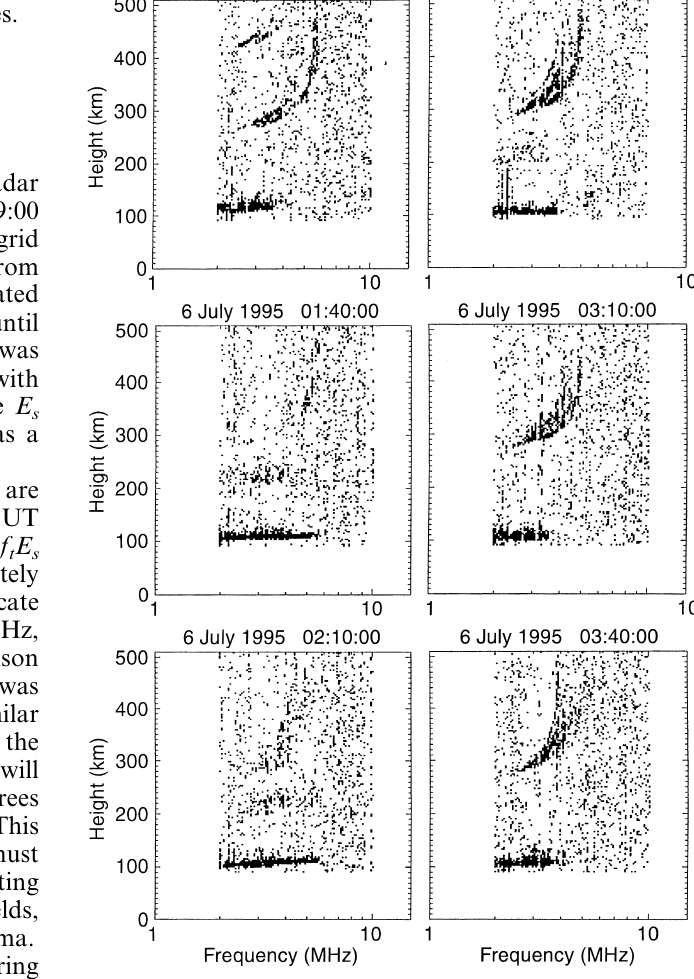
Fig. 4. Ionograms during a period of intense HF backscatter from ~01:00 to 04:00 UT 6 July 1995 obtained with a digital ionosonde located at Termignon (~18 (cid:176) azimuth, ~200-km range with respect to the Valensole HF radar). The detection of the F -region traces during Valensole backscatter occurrence suggests that E s is strongly transparent at these times, which implies irregular electron-density structuring and thus electron-density gradients in the horizontal